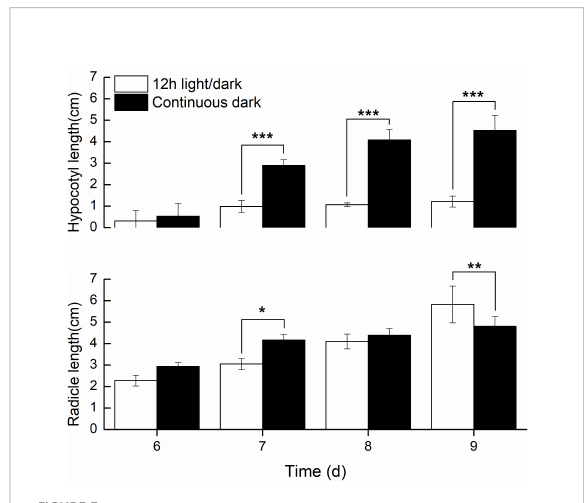
FIGURE 3 Radicle and hypocotyls lengths developed in light and dark.